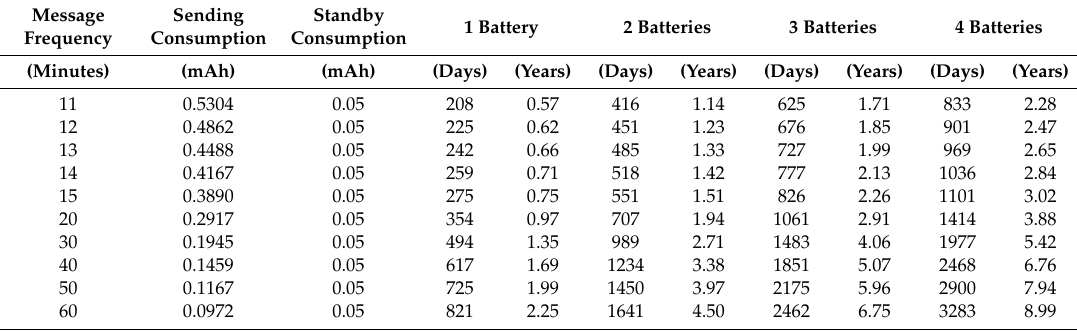
Table 1. Autonomy of the device expressed in days and years depending on the number of batteries connected in parallel.